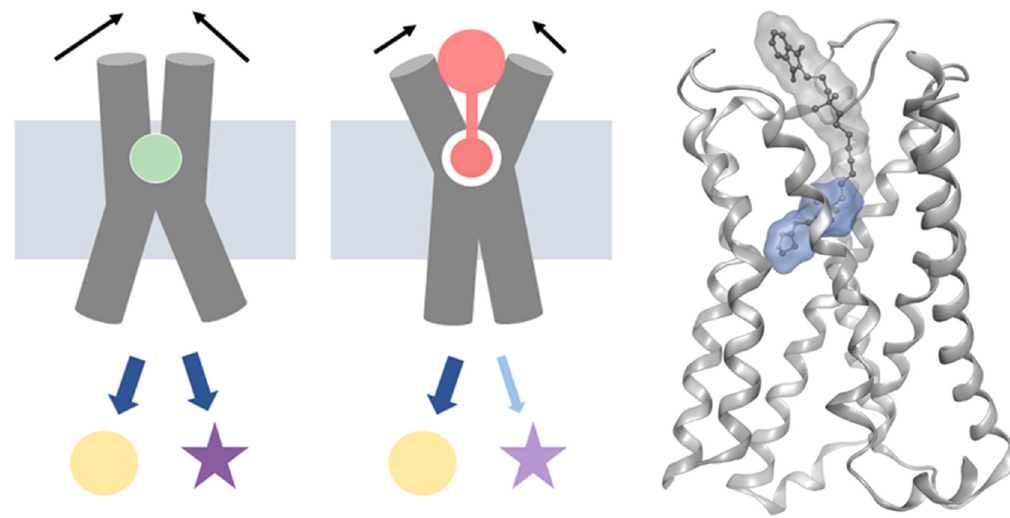
Figure 1. A schematic representation of the general activation mechanism illustrates the full signaling repertoire of a classical orthosteric agonist (left, green circle) and the restricted conformational freedom by extended molecular motives (middle, salmon shape) resulting in biased signaling. One example of such extended (bitopic) ligands is iper-8-phth, which is shown on the right in its proposed binding mode at the M 1 receptor [22]. While the iperoxo building block (blue surface) binds to the orthosteric binding pocket, the extended molecular structure (grey shape) spatially interferes with extracellular loop regions.